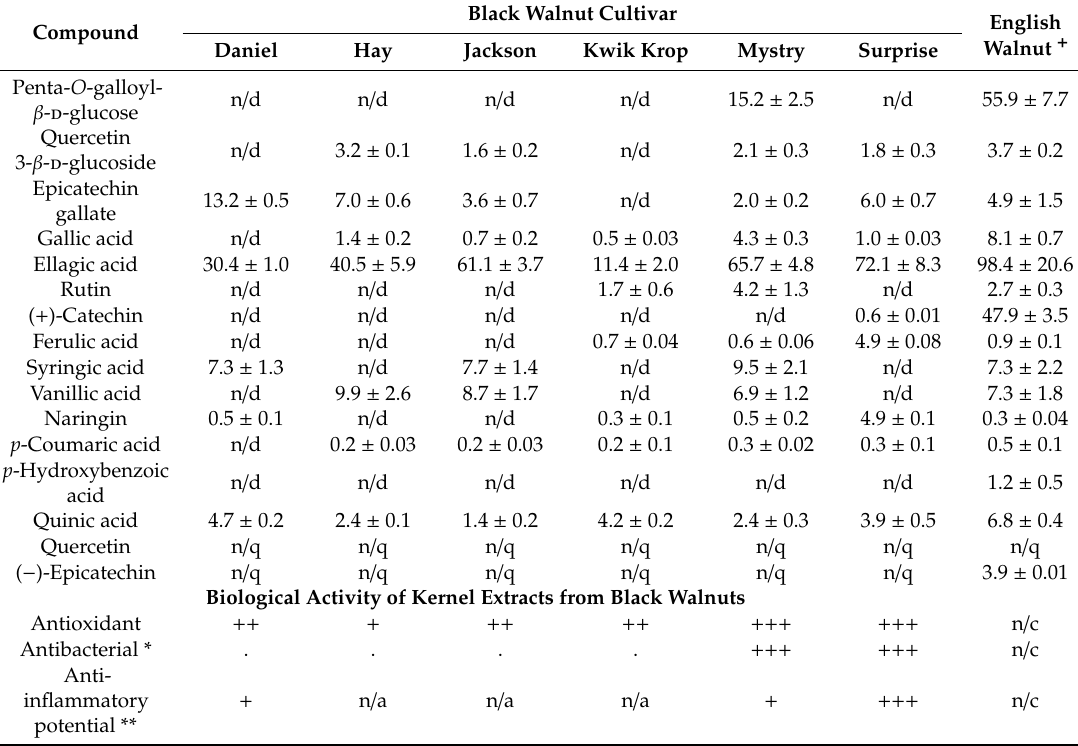
Table 3. Concentrations of phenolic compounds ( µ g / g of dry weight) in kernels of six black walnut cultivars with their known bioactive activities